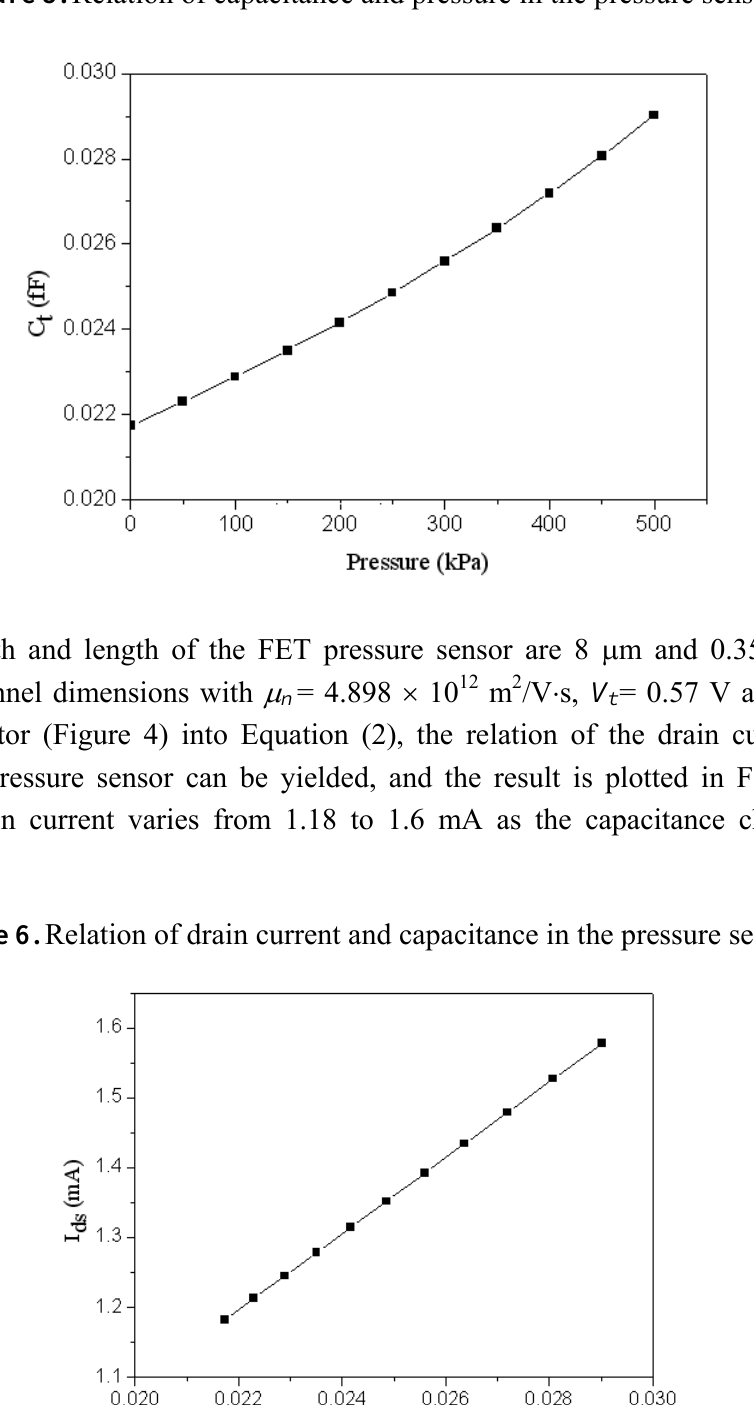
Figure 5. Relation of capacitance and pressure in the pressure sensor.